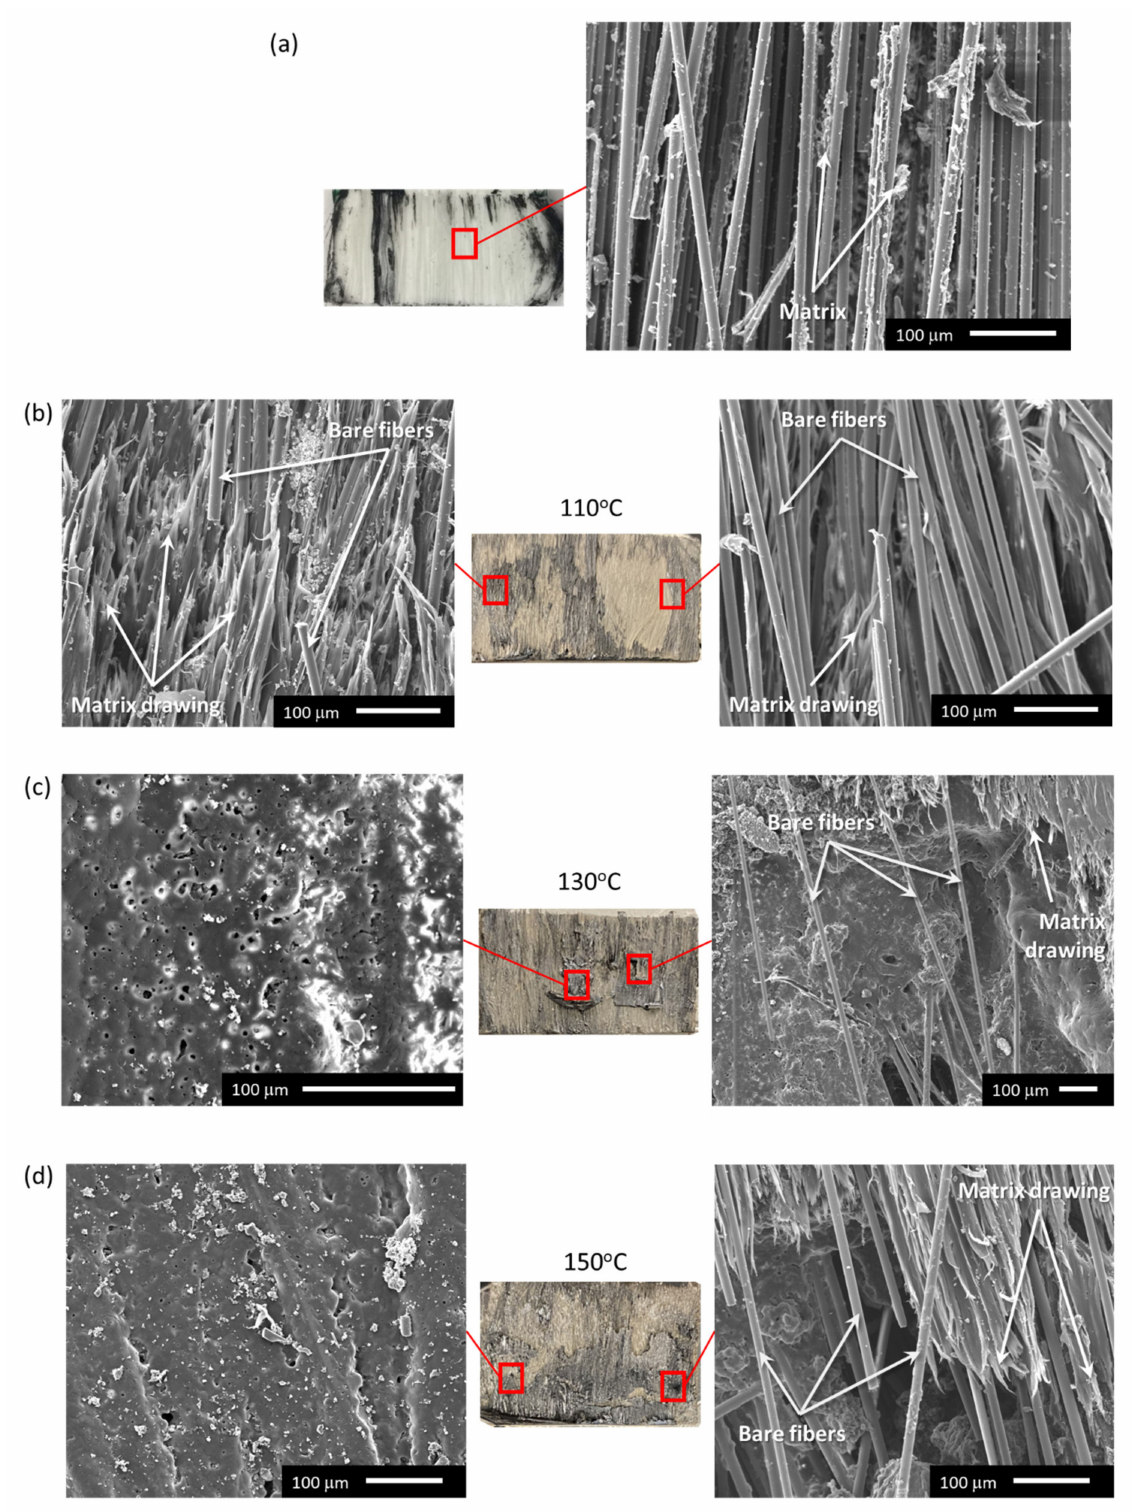
Figure 12. Representative fracture surfaces and SEM micrographs of samples welded with 20 wt.% MWCNT/PP films after disassembly process: ( a ) comparison with room temperature fracture surface images, reproduced and modified from [36] with permission; ( b ) disassembly at 110 ◦ C; ( c ) disassembly at 130 ◦ C; ( d ) disassembly at 150 ◦ C. All scale bars are 100 µ